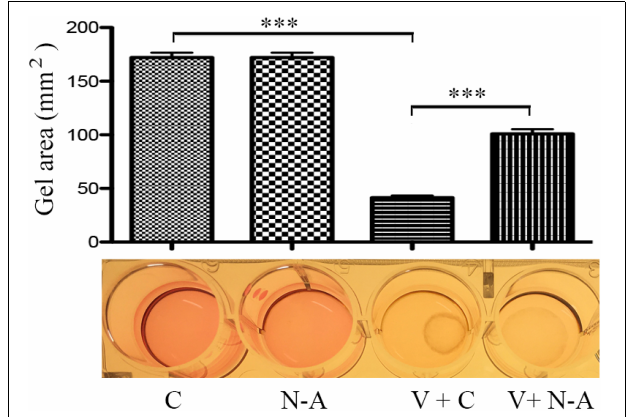
FIGURE 7 | Blocking IL13R α 2 prevents vitreous-induced contraction of RPE cells. After the mixtures of ARPE-19 cells with collagen I solution formed a collagen gel, they were treated with DMEM/F12 + an antibody or vitreous + an antibody for 48 h. C, control antibody; N-A: neutralizing antibody against IL13R α 2; V + C, vitreous + control antibody; V + N-A, vitreous + neutralizing antibody against IL13R α 2. ∗∗∗ denotes 0.001, using paired t test.